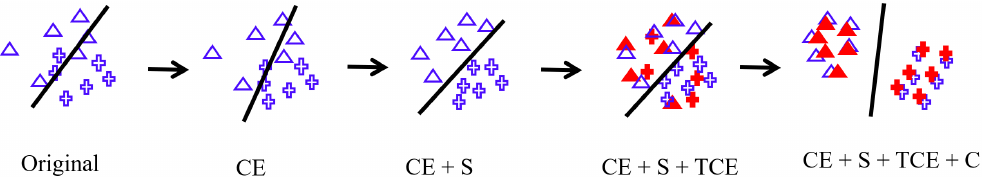
Figure 3. A toy example of our SCTL learning paradigm. The blue color is the training data, and the red color is the test data. “Original” is the binary classification problem, “CE” refers to performing cross-entropy loss in training data, “CE + S” minimizes the proposed separation to enlarge differences between the two classes. “CE + S + TCE” can additionally minimize the pseudo labeled test data using the cross-entropy loss. “CE + S + TCE + C” adds another categorical maximum mean discrepancy loss to reduce the divergence between training and test data and form our SCTL